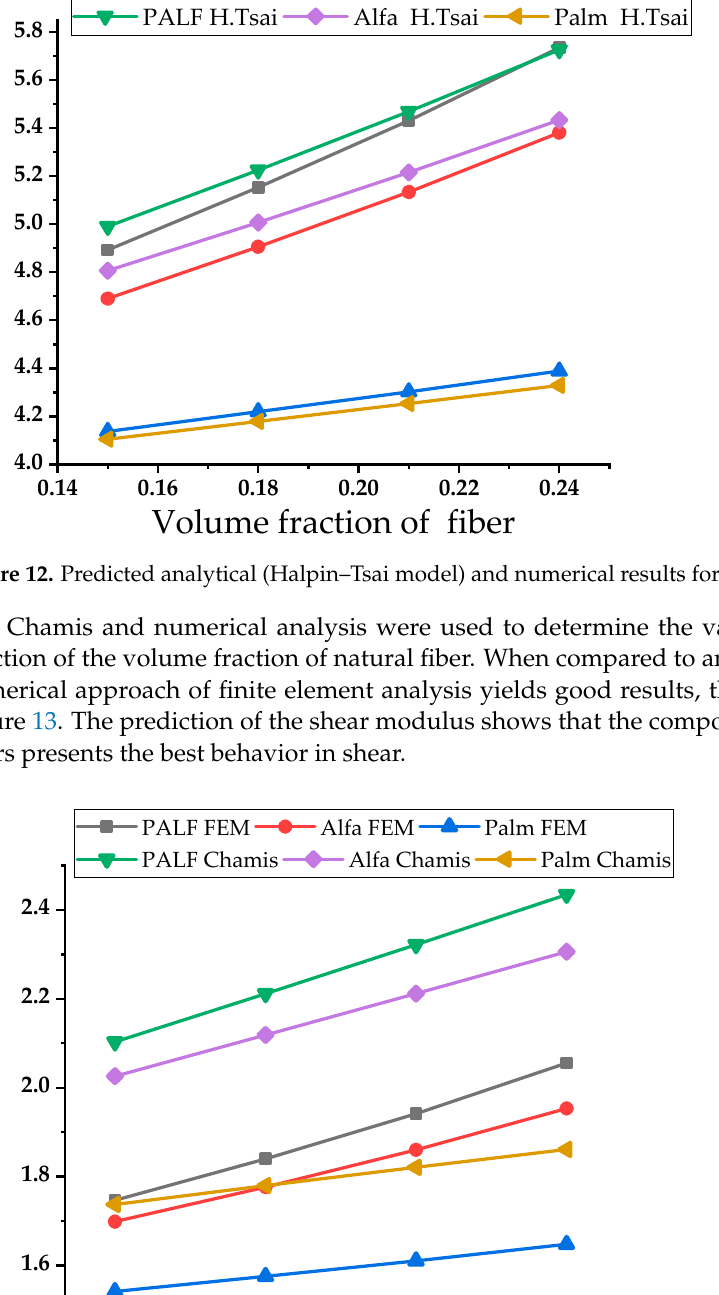
Figure 11. Predicted analytical (Halpin–Tsai model) and numerical results for 𝐸 (cid:2869)(cid:2869) in terms of 𝑉 (cid:3007) .